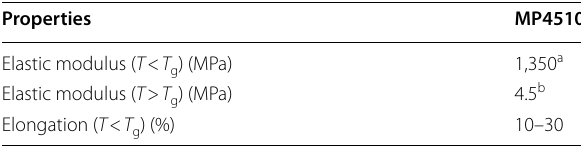
Table 2 Characteristics of SMP